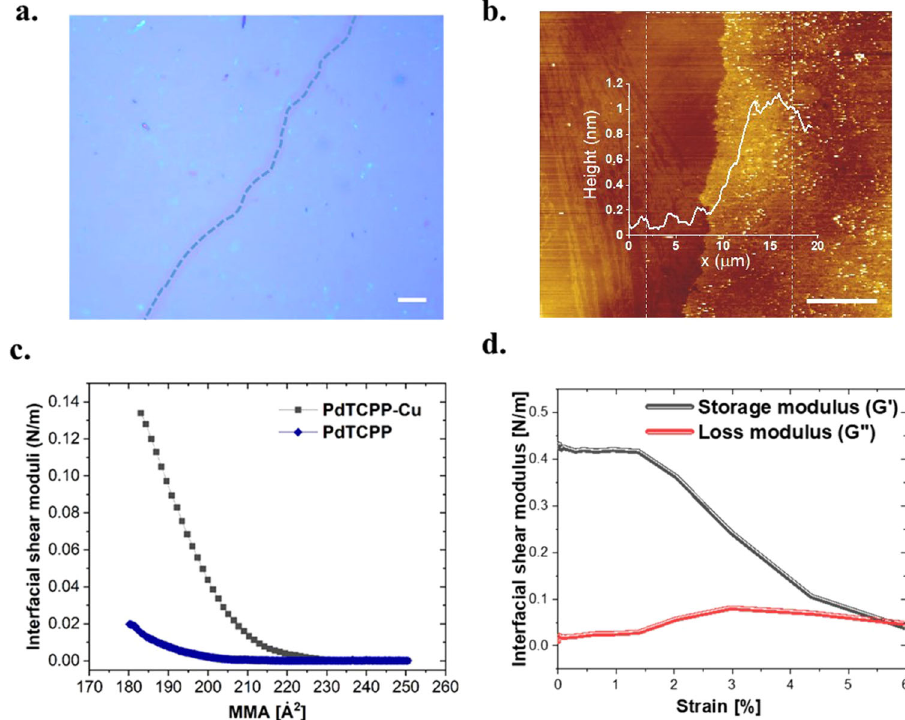
Fig. 2 Morhphology and rheology of the 2D MOF. a Optical microscopy image of monolayer PdTCPP-Cu deposited on Si with 300 nm SiO 2 (scale bar = 10 µm). The dashed line indicates the centerline of scratch created to visualize the layer. b AFM image of the PdTCPP-Cu on Si covered with 300 nm SiO 2 (inset: averaged height pro fi les along the scratch of the area circled with dashed line), scale bar = 10 µm. c Interfacial shear storage modulus of PdTCPP and PdTCPP-Cu fi lm at the air-water interface at a frequency of 1 Hz and Strain of 1%, PdTCPP monolayers in Cu 2 + aqueous solution (black) and pure water (blue) as subphases. d Variation in interfacial shear moduli with strain amplitude sweep at the frequency of 1 Hz. Interfacial storage (black line) and loss modulus (red line) of PdTCPP-Cu fi